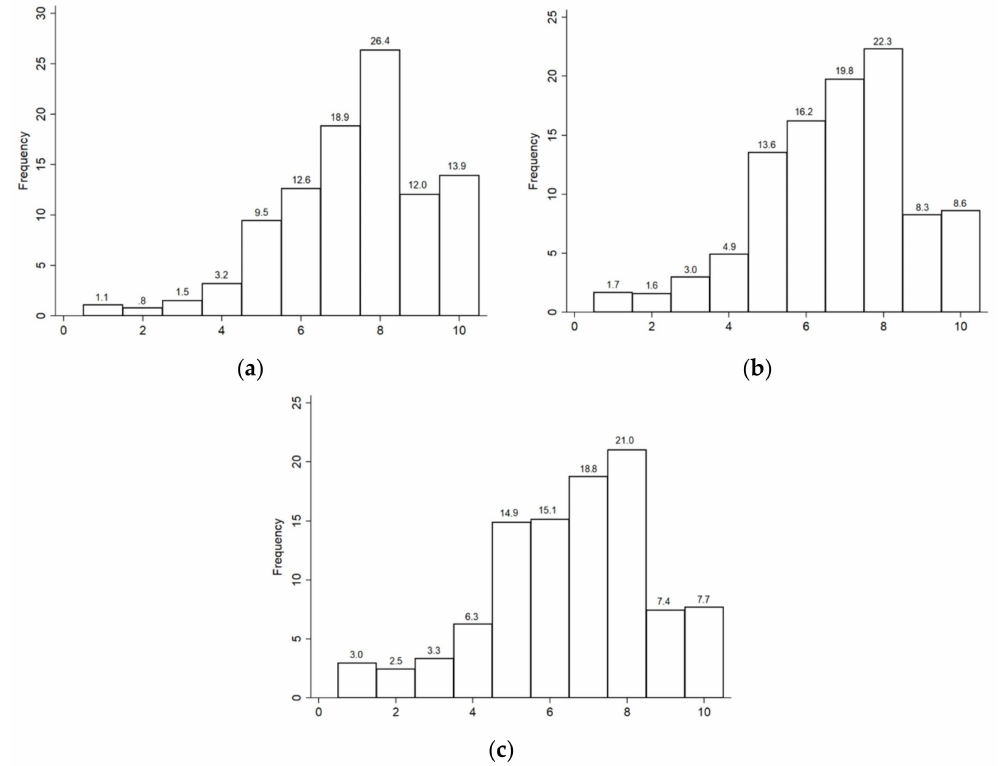
Figure 1. Distribution of frequencies of the overall self-reported experience with the Spanish health services: ( a ) Primary care; ( b ) Specialised care; ( c ) Hospital care. Data from the Spanish Centre for Sociological Research, Spanish Healthcare Barometer survey,